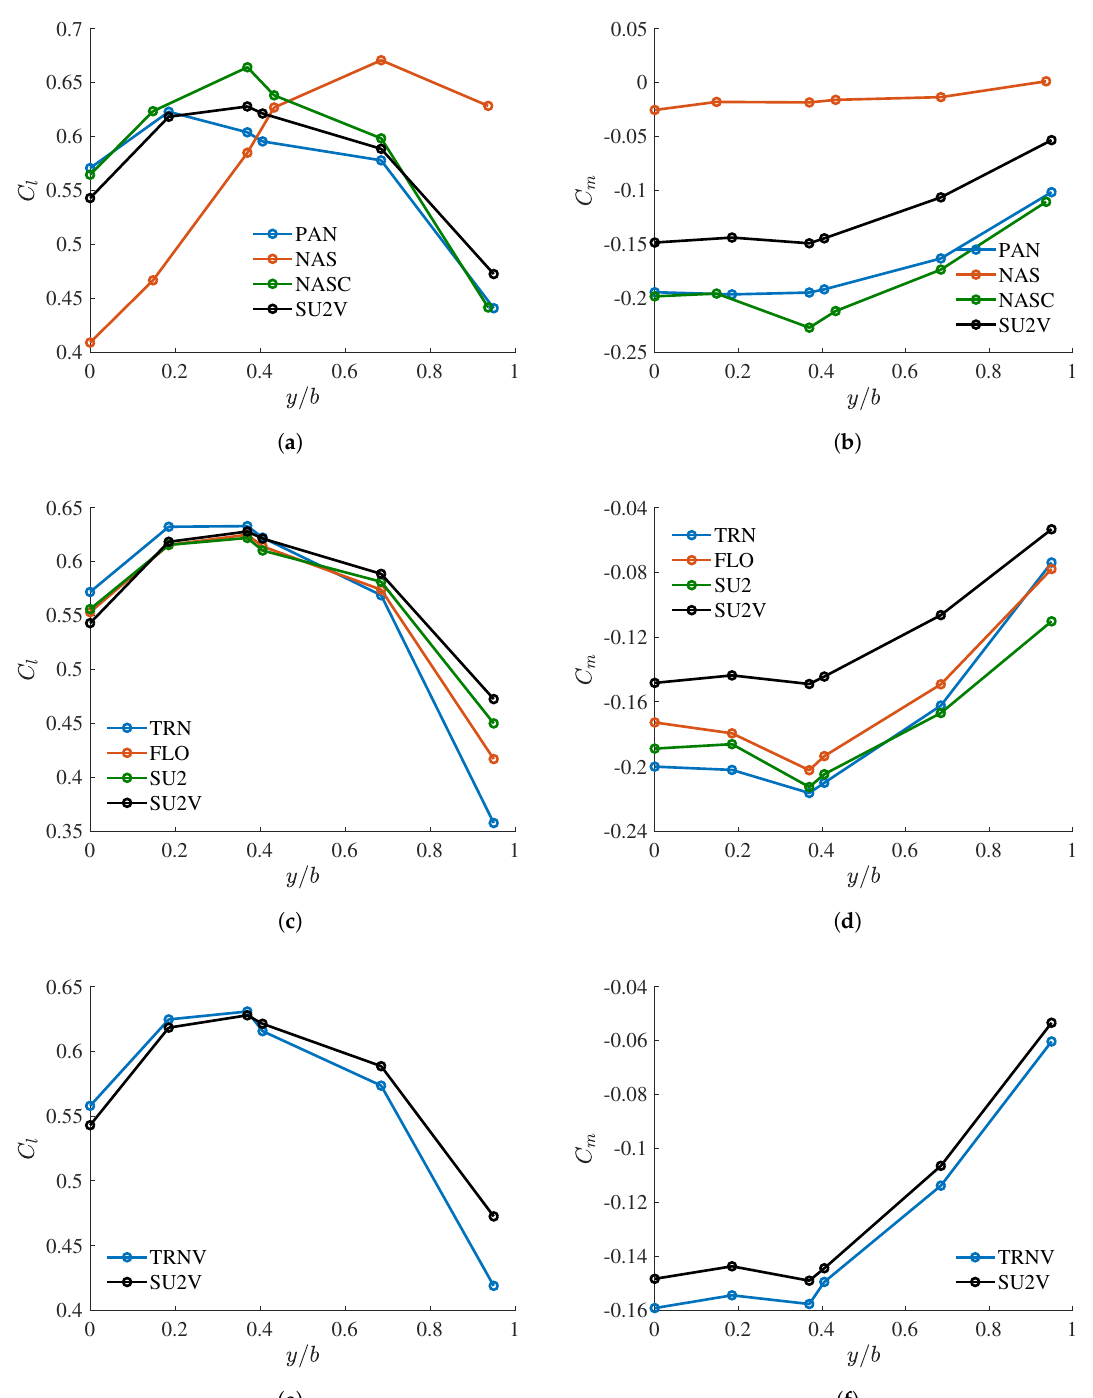
Figure 6. Sectional aerodynamic loads along the span of the Embraer Benchmark Wing at Mach 0.78 and lift coefficient 0.60 obtained from different levels of fidelity: ( a ) lift for linear models; ( b ) moment for linear models; ( c ) lift for nonlinear inviscid models; ( d ) moment for nonlinear inviscid models; ( e ) lift for viscous models; and ( f ) moment for viscous